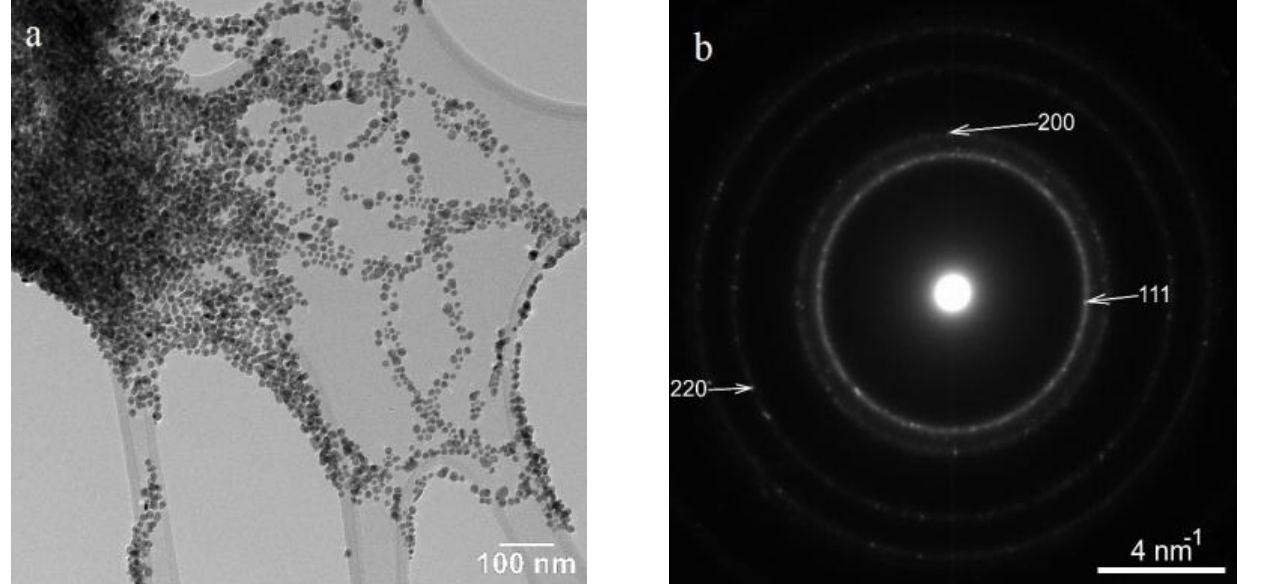
Figure 7. An agglomeration of AgNPs ( a ) and the electron diffraction pattern revealing the FCC (face-centered cubic) structure of Ag ( b ); the most intense diffraction rings correspond to (111), (200), and (220) crystallographic planes.